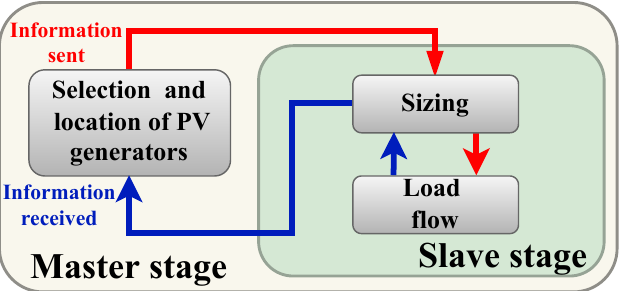
Figure 4. Master–slave methodology for the optimal integration of distributed generators into electrical